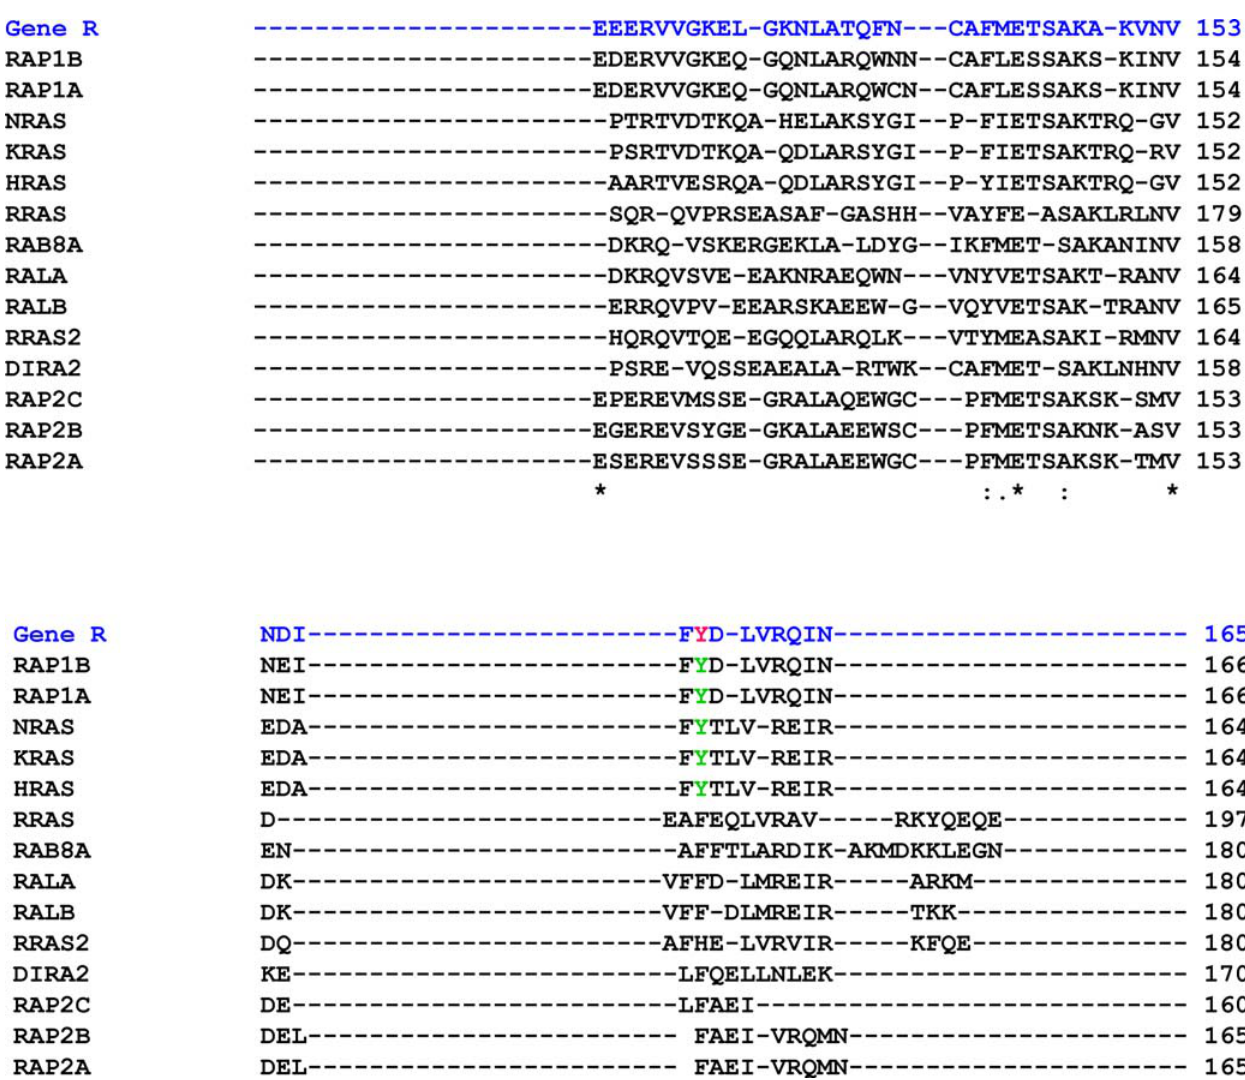
Figure 3. Tyrosine phosphorylation in Roughened (Gene R) from Drosophila is conserved in human H-RAS, K-RAS, N-RAS and R- RAS. The Drosophila protein sequence (blue with the phosphorylated tyrosine in red) aligns with several human protein sequences (black). The conserved tyrosines in the human proteins are highlighted in green.